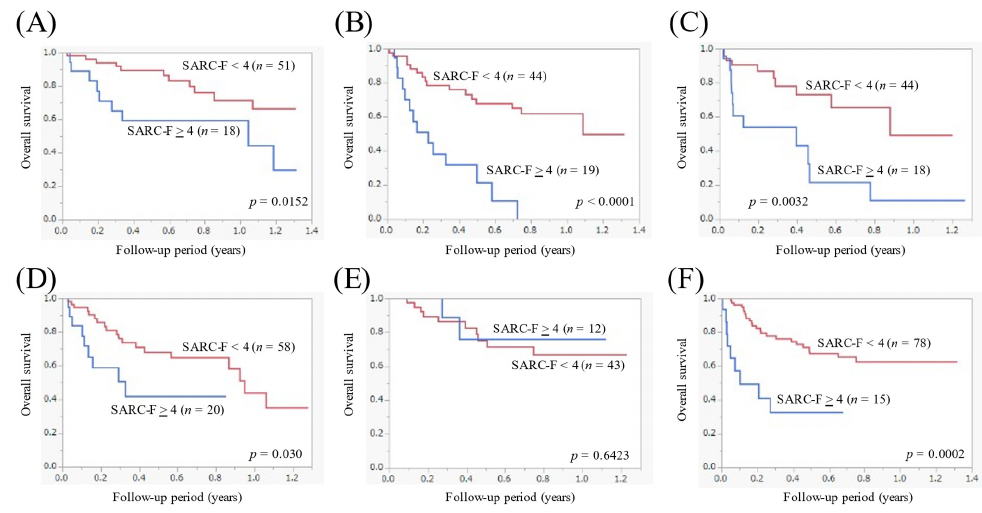
Figure 3. Kaplan-Meier curves in patients with a SARC-F score ≥ 4 and <4 according to the disease primary site. ( A ) Esophageal cancer ( n = 69). ( B ) Gastric cancer ( n = 63). ( C ) Biliary tract cancer ( n = 62). ( D ) Pancreatic cancer ( n = 78). ( E ) Hepatocellular carcinoma ( n = 55). ( F ) Colorectal cancer ( n = 93).